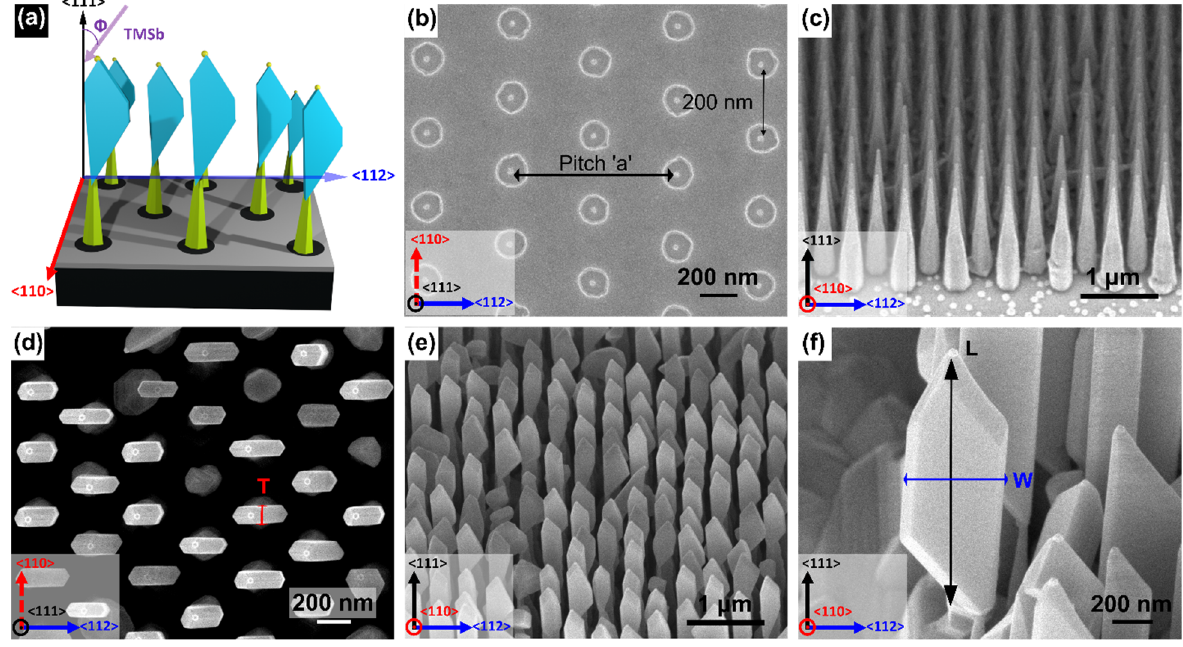
Figure 1. ( a ) Three-dimensional representation of the directional growth configuration with TMSb injector forming an angle Φ of 38° with the normal substrate direction <111>. The in-plane Sb beam projection is aligned with the pitch direction <112>. ( b ) Top-view SEM image of a lithographically patterned InP(111)B substrate with 20 nm-thick SiO 2 mask and Au discs having a pitch 𝑎 of 700 nm. ( c ) 45° tilted SEM image of InP NW stems grown for 60 min on the substrate shown in panel ( b ). ( d ) Top-view and ( e ) 45° tilted SEM image of InP-InSb NFs obtained after 60 min growth of InSb. ( f ) Magnified 45° tilted SEM image of an individual InSb NF. Panels ( d , f ) show the measured geometrical parameters of InSb NFs: thickness 𝑇 was measured using top-view images, width 𝑊 and length 𝐿 were measured using tilted images and corrected by the geometrical factor due to the tilt angle. The crystallographic directions are given at the bottom left corner of the panels.